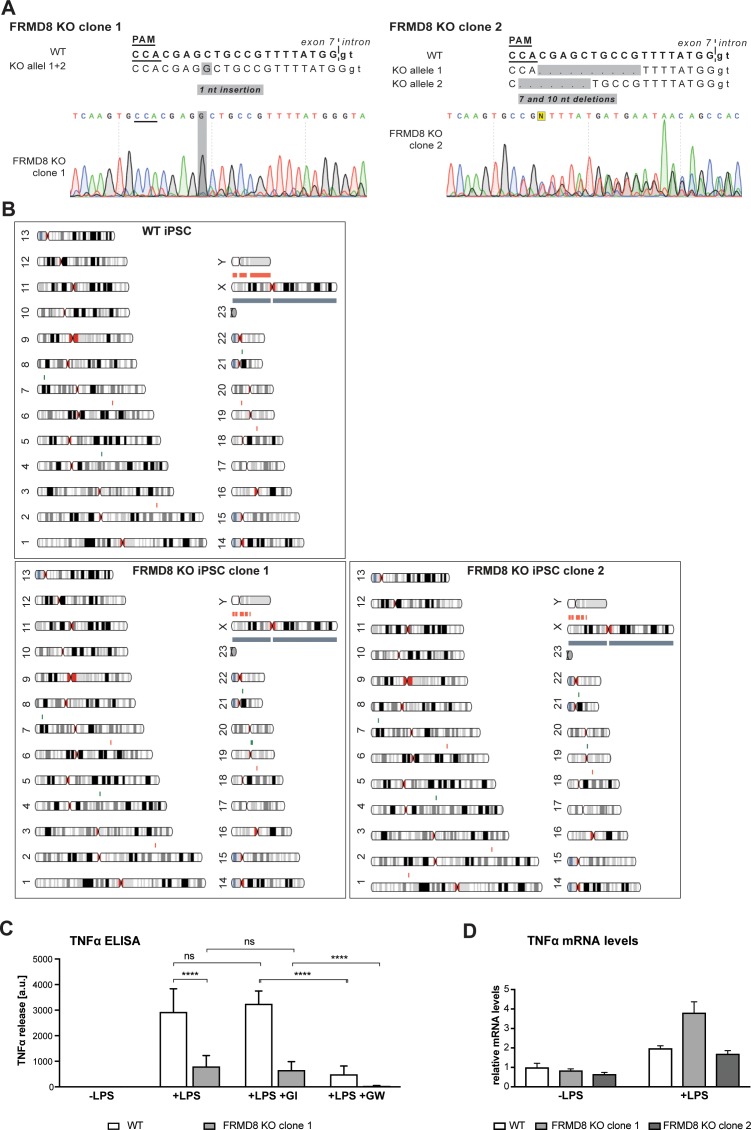
Generation of FRMD8 knockout iPSCs and iPSC-derived macrophages.(A) Sequencing of the genomic DNA isolated from clonal FRMD8 KO iPSCs shows a 1-nt insertion (clone 1) and a 7-nt and 10-nt deletion (clone 2). The targeting sequence of the sgRNA is shown in bold; small letters indicate the sequence within the intronic region; the protospacer adjacent motif (PAM) sequence underlined. (B) Parental wild-type and FRMD8 KO iPSC lines were karyotyped by SNP array. Detected copy number variations are indicated in red (DNA copy number loss in the indicated region) and green (DNA copy number increase). The AH017-13 iPSC line used was derived from a female donor, therefore the Y chromosome is marked in red (loss of Y chromosome DNA). (C) 25,000 iPSC-derived macrophages were either left unstimulated, stimulated with 50 ng/ml LPS, or with 50 ng/ml LPS and simultaneously with 2 μM GI or 2 μM GW for 4 hr. TNFα concentration in the cell supernatants was measured by ELISA and then normalised to the protein concentration in macrophage cell lysates to adjust the cytokine release for potential differences in cell numbers. Each experiment was performed in biological triplicates. Data from three independent experiments were statistically analysed using a Mann-Whitney test; ns = p value>0.05; ****=p value<0.0001. (D) TNFα mRNA levels relative to actin mRNA levels were measured by TaqMan PCR in WT and FRMD8 KO iPSC-derived macrophages without stimulation and after stimulation with 200 ng/ml LPS for 0.5 hr.